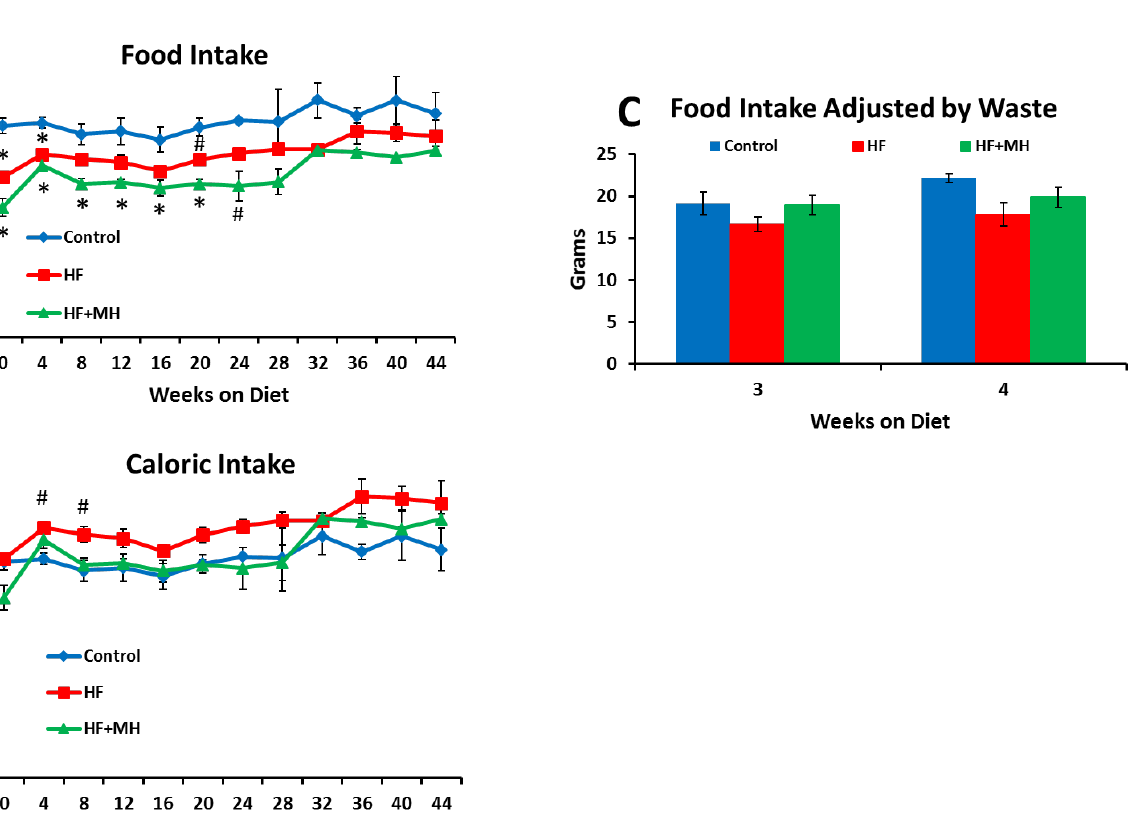
Figure 2. ( A ): Weekly food intake per mouse at weekly intervals on the diets. (Ns = 7–8). ( B ): Weekly caloric intake at weekly intervals on the diets. (Ns = 7–8). ( C ): Weekly food intake per mouse at weeks 3 and 4 on the diets adjusted for food waste, with mice housed individually in suspended cages (Ns = 8–10). # = p < 0.05 & * = p < 0.01 compared to controls.